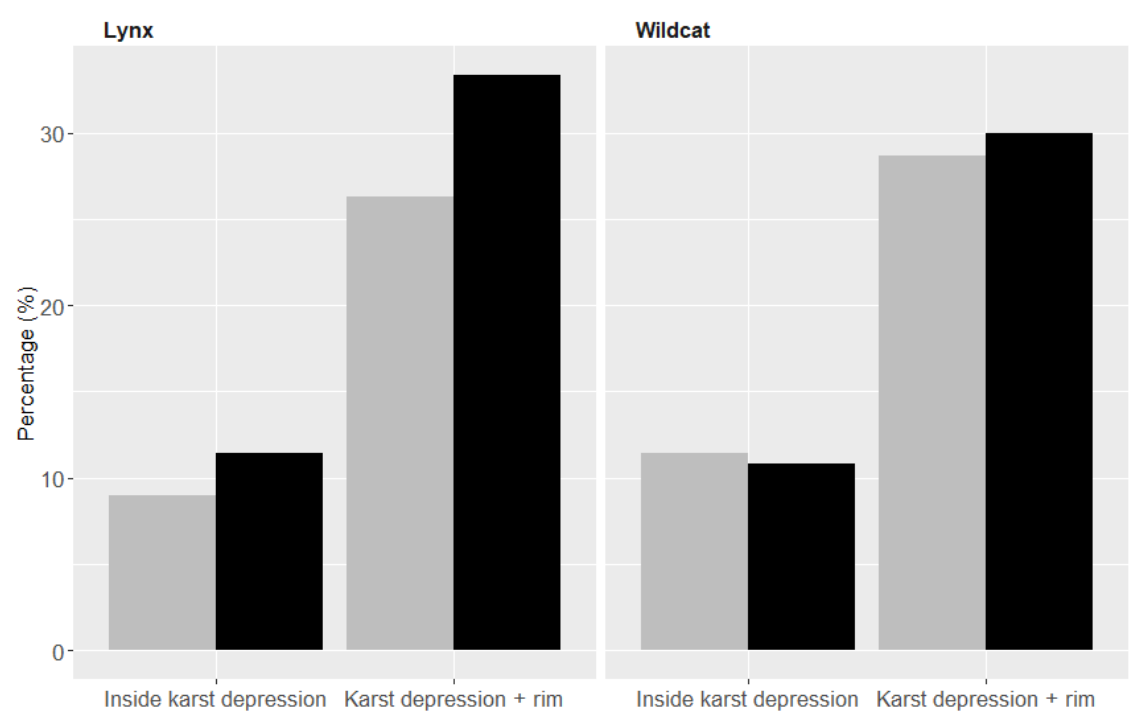
Figure 4. Selection of karst depressions by lynx ( left ) and wildcats ( right ), indicated by comparison of random points inside the tracked animals’ home ranges (availability; grey) and felid GPS points (use; black). ‘Inside karst depression’ refers to areas inside karst depressions, while ‘Karst depression + rim’ includes also a 15 m buffer to account for the rims of these depressions, as well as GPS-error of telemetry collars. Table 2. Generalized linear models for habitat selection of Eurasian lynx and European wildcats in respect to their GPS locations, as well as locations of lynx kill sites. Covariate depressions and roads represent the distance to the nearest karst depression and forestry road, respectively. k—number of model variables; AIC—Akaike’s information criterion; ρ —Spearman rank correlation; CI—confidence interval.